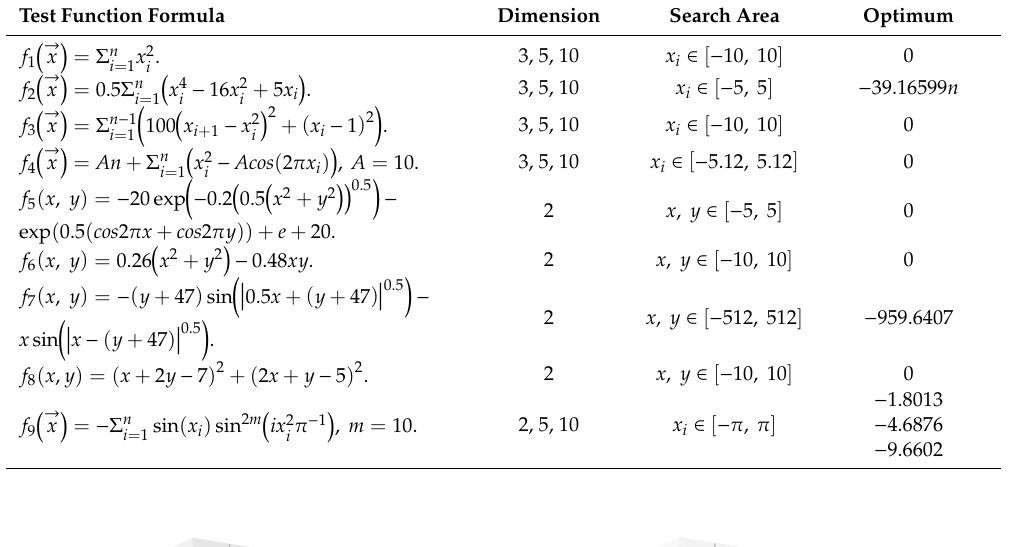
Table 1. Test functions used to benchmark the hybrid optimization algorithms.